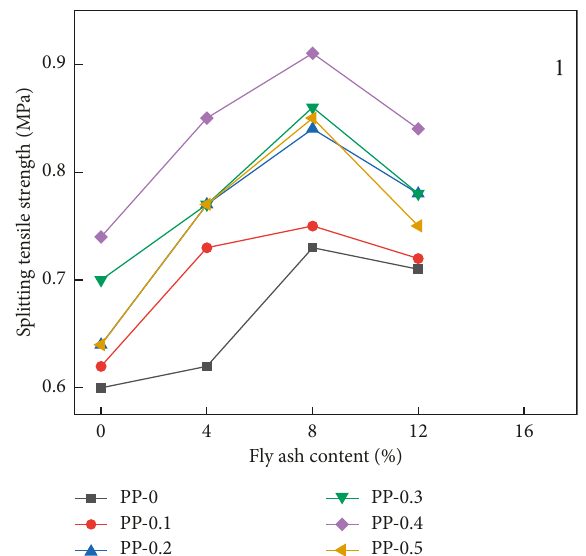
Figure 7: Relationship between splitting tensile strength and fly ash